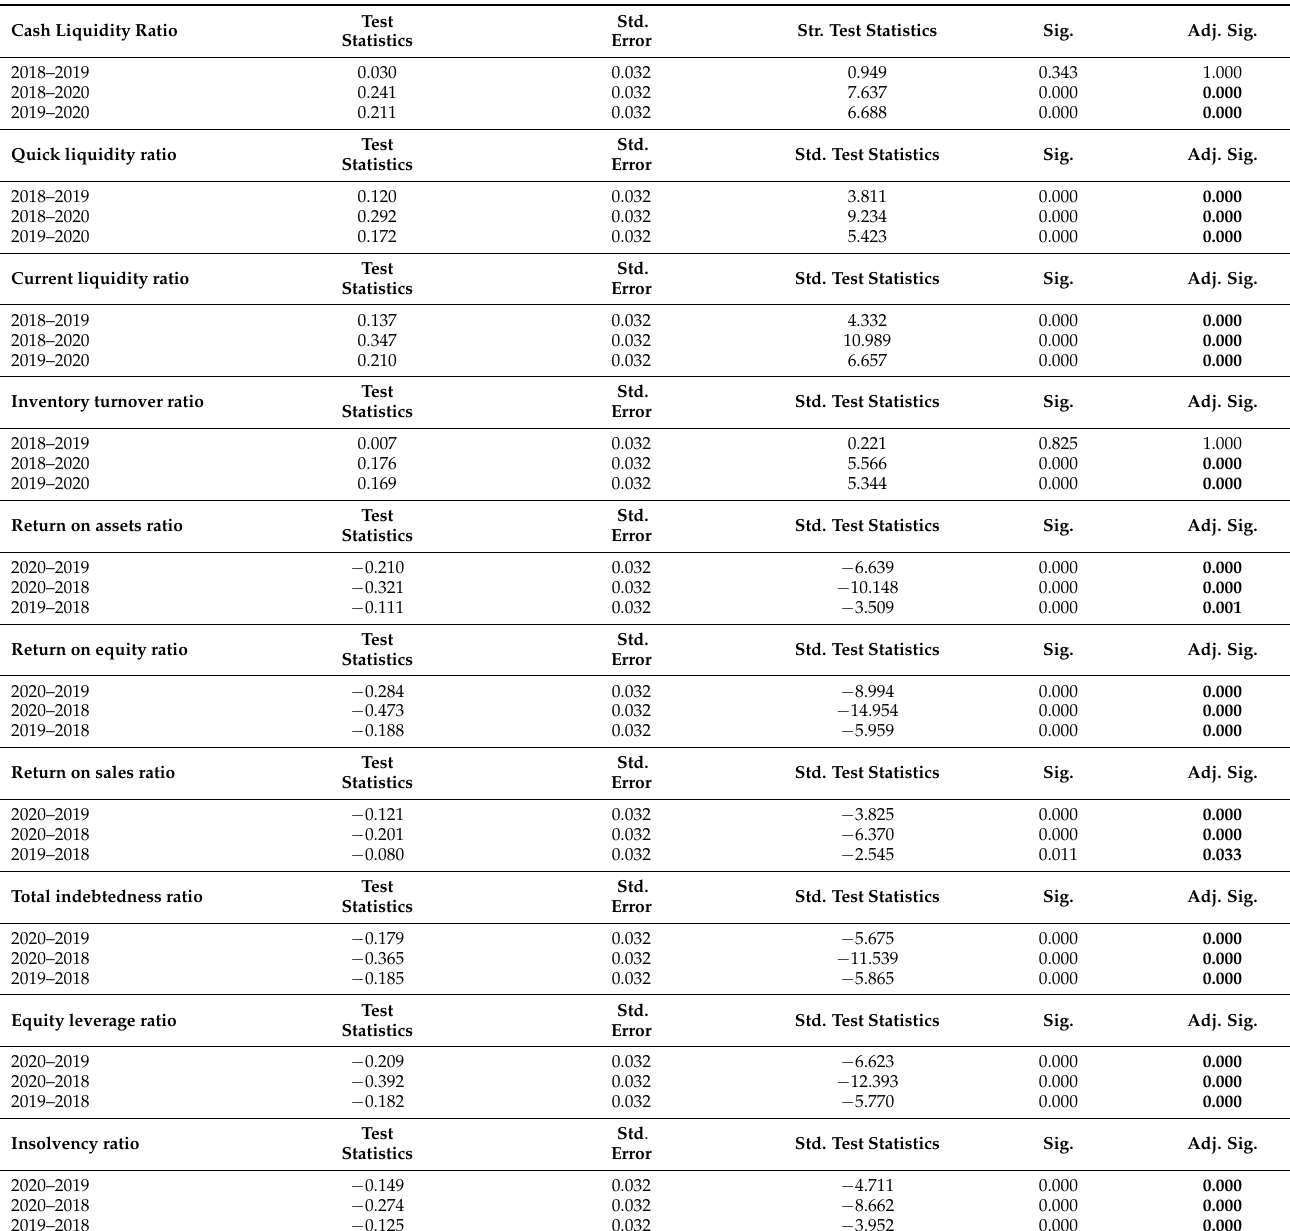
Table 9. The output of the pairwise comparison of the monitored